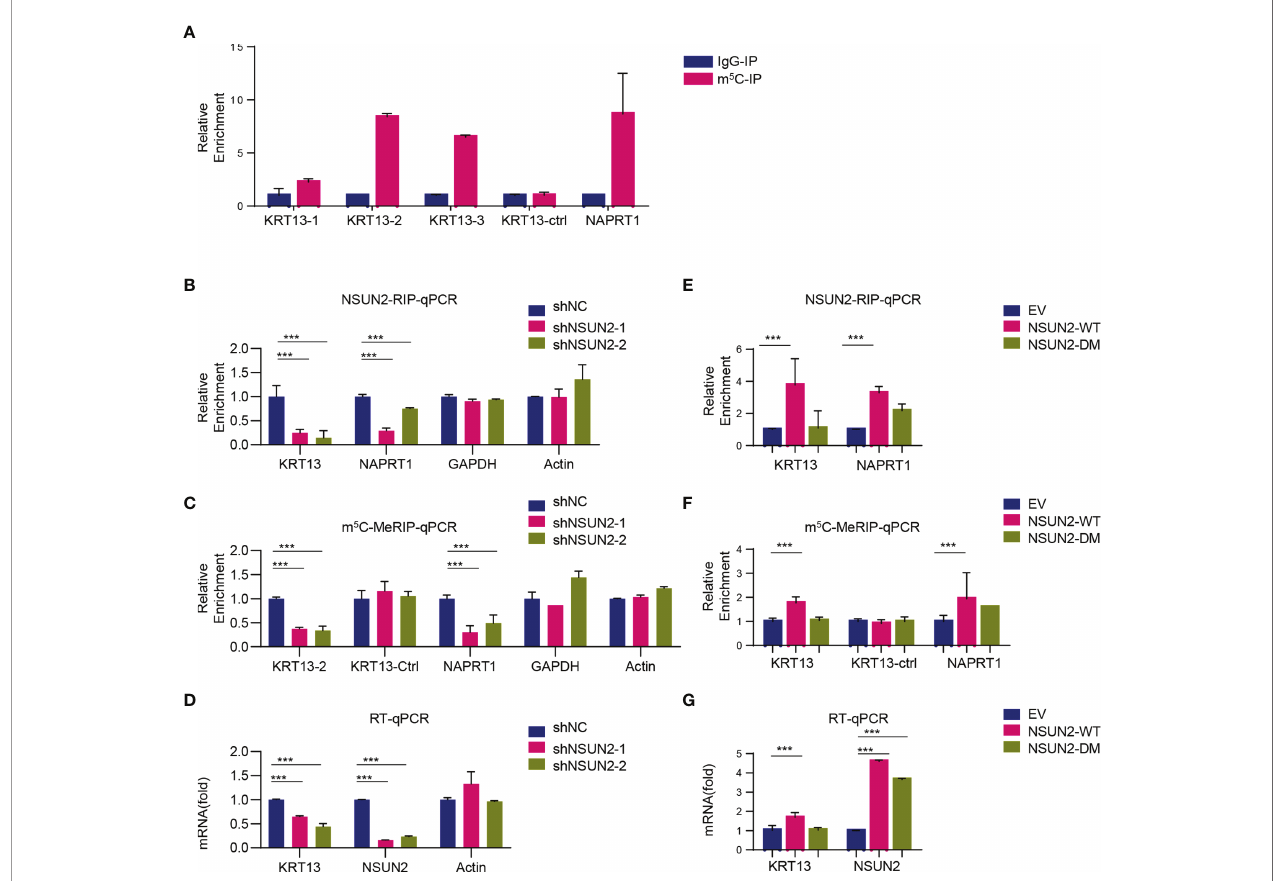
FIGURE 5 | KRT13 mRNA is enriched of m 5 C modi fi cation. (A) m 5 C modi fi cation on KRT13 mRNA analyzed by m 5 C-MeRIP-qPCR in CaSki cells. NAPRT1 was used as a positive control. (B – D) RIP analysis of NSUN2- KRT13 interaction (B) and m 5 C-MeRIP-qPCR detection of m 5 C level on KRT13 (C) along with RT-qPCR analysis of KRT13 mRNA level (D) in NSUN2 knockdown and control CaSki cells. GAPDH and Actin were used as a negative control. (E – G) RIP analysis of NSUN2- KRT13 interaction (E) and m 5 C-MeRIP-qPCR detection of m 5 C level on KRT13 (F) along with RT-qPCR analysis of KRT13 mRNA level (G) in wild-type and mutant NSUN2 overexpressed CaSki cells. (Data shown are mean ± SEM, n = 3; Student ’ s unpaired t -test was used for statistical analysis, *** p <